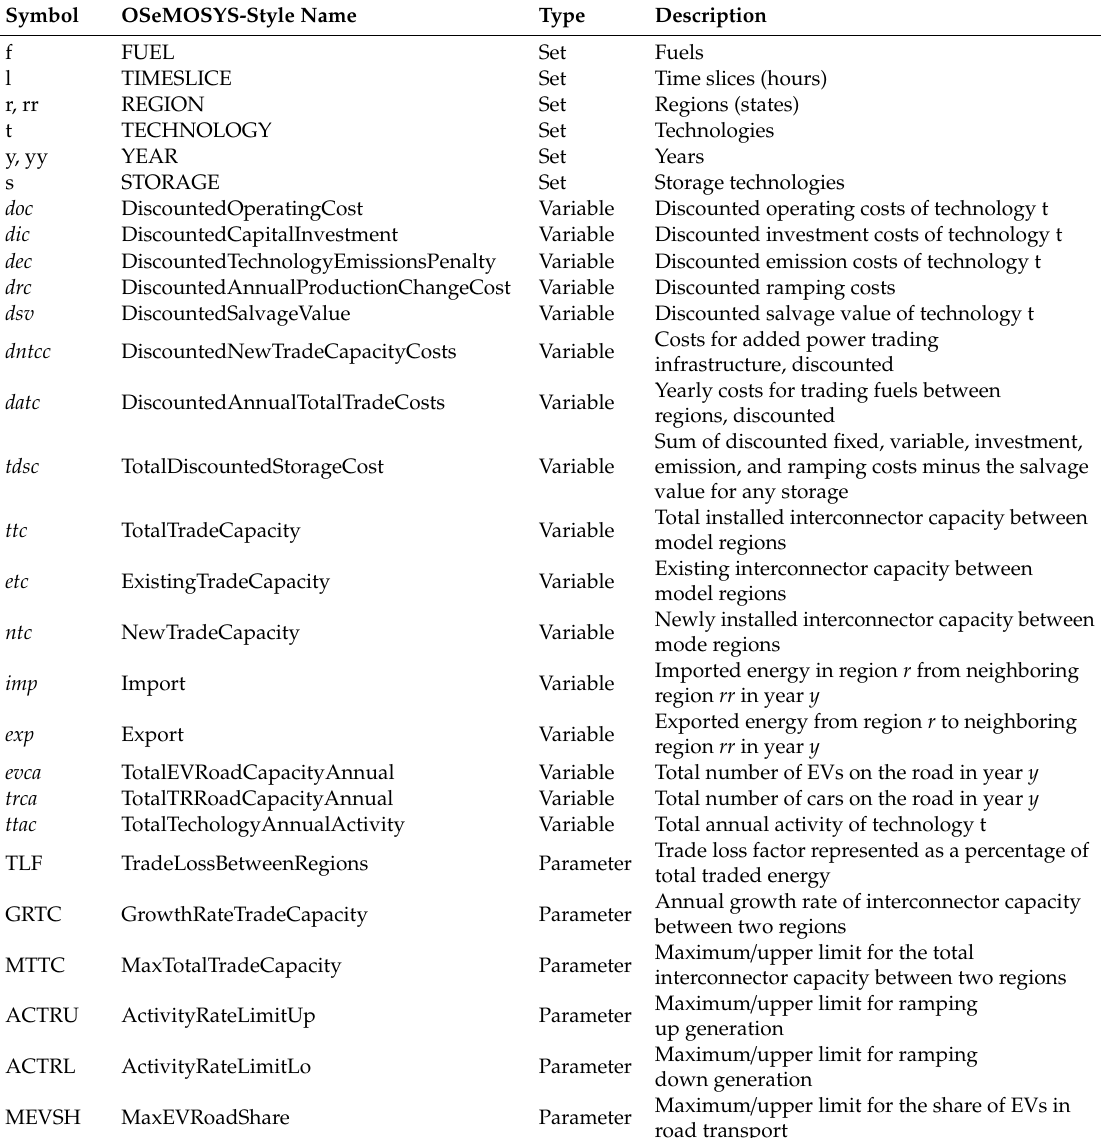
Table A1. Definition of sets, parameters and